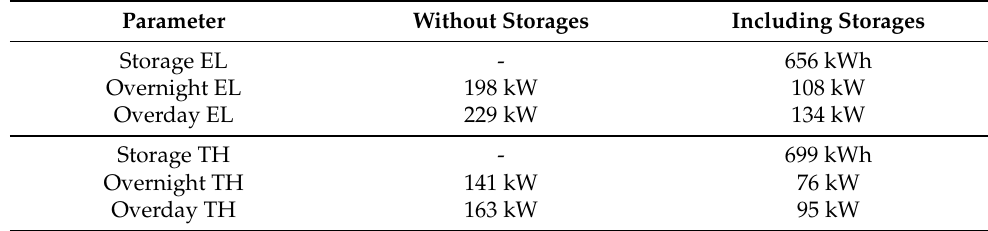
Table 4. Power Demand in the Neighbourhood.